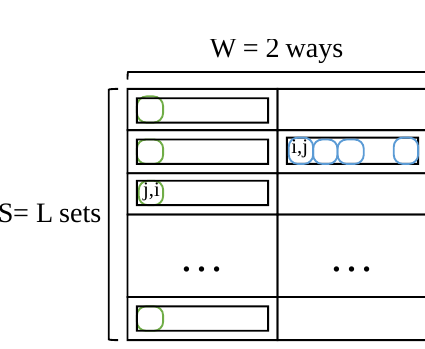
Figure 4. Set-associative cache holding a whole tile ( T = L ), with S